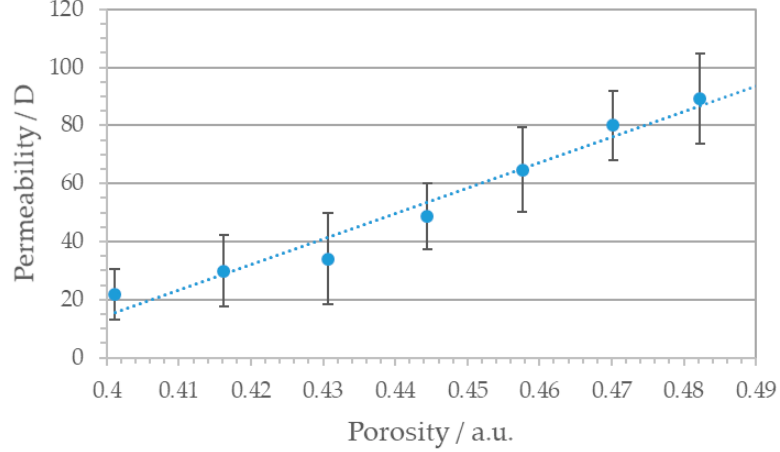
Figure 6. Correlation between permeability K and porosity of the square patterned SLM structures. With increasing porosity permeability rises from 20D to nearly 100D.